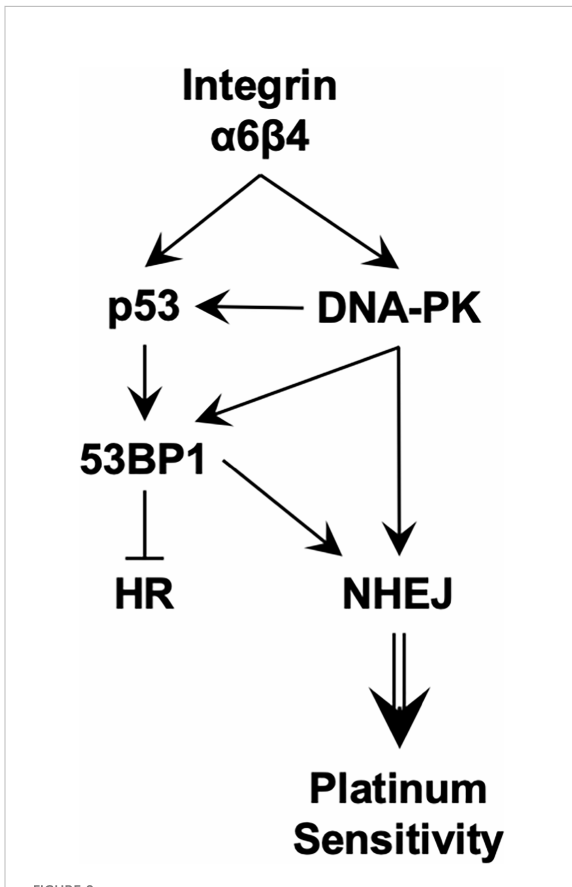
FIGURE 8 Proposed signaling downstream of integrin a 6 b 4 that promotes sensitivity to platinum